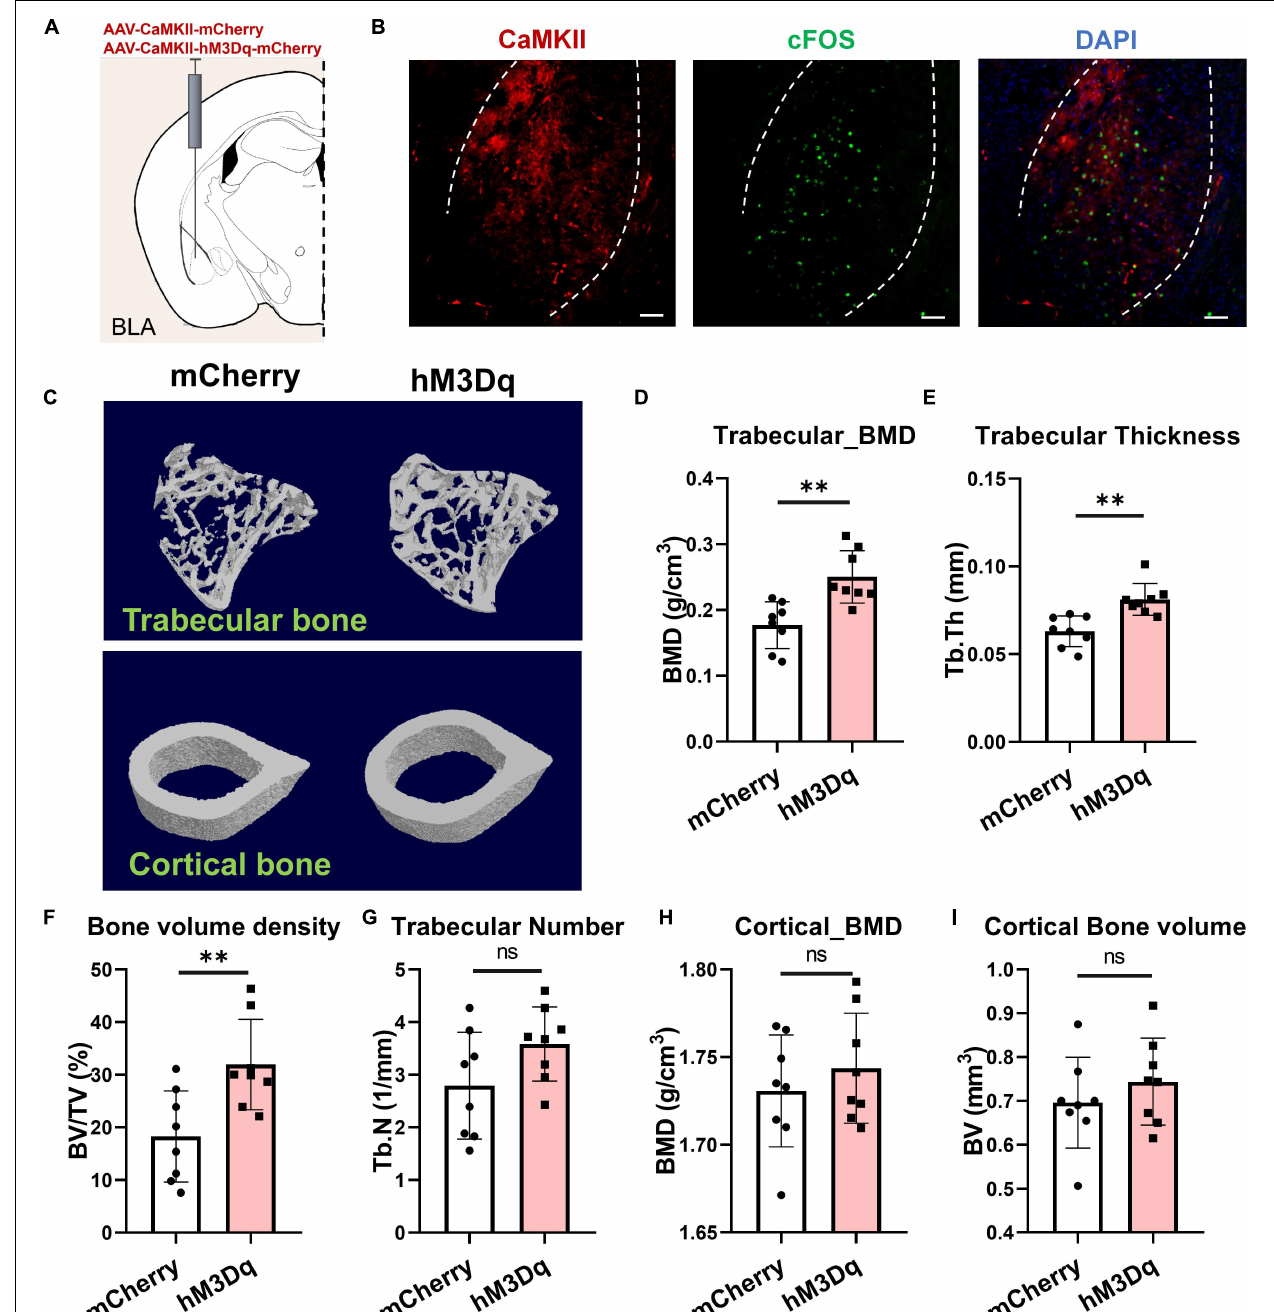
FIGURE 3 | Activation of BLA CaMKII neurons accelerates bone formation. (A) Chemogenetic stimulation of BLA CaMKII neurons. (B) Representative confocal images of cFos+(green) and chemogenetically labeled BLA CaMKII neurons in BLA CNO i.p. treatment. Scale bar, 50 µ m. (C) Representative µ CT images of trabecular and cortical bones. (D–I) Quantitative analysis of µ CT images of bone parameters. (D) Trabecular BMD, (E) trabecular thickness, (F) trabecular volume fraction, (G) trabecular number, (H) cortical BMD, and (I) cortical bone volume. N = 8 (mCherry group), N = 8 (hM3Dq group). ∗∗ P < 0.01, ns means not significant. All data represent mean ± SD; statistical analysis was assessed using Student t -test for panels (D–I) .